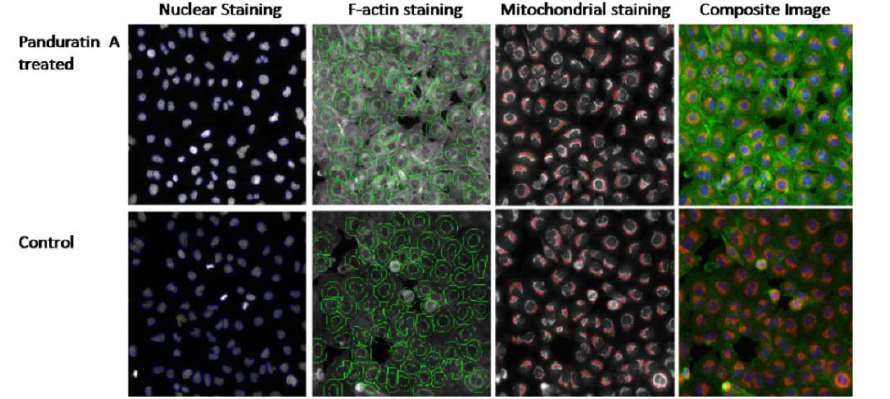
Figure 8. Fluorescence photomicrographs of panduratin A-induced changes in apoptosis parameters acquired from the ArrayScan HCS Reader. Effects of incubation of A549 cells with panduratin A, compared to controls, respectively, on nuclear area, mitochondrial membrane potential and F-actin. Circular outlines indicate the areas within cells in which fluorescence intensity is measured.